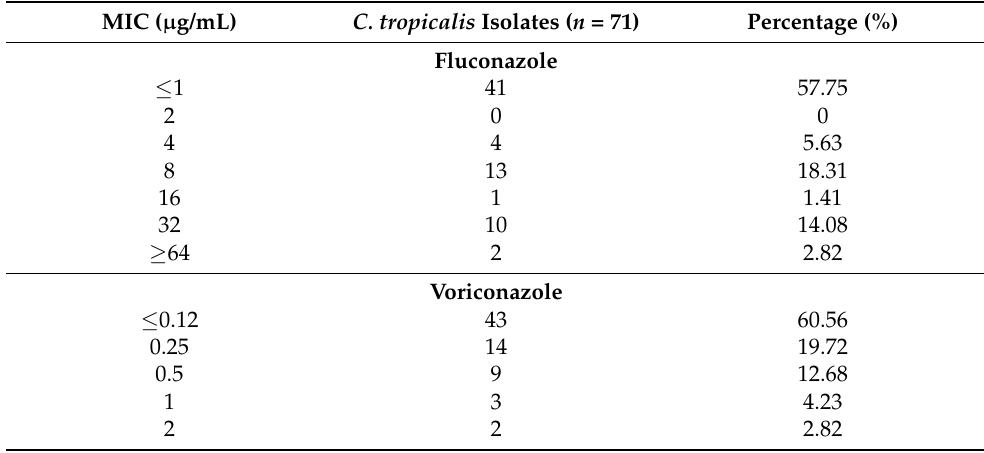
Table 2. Fluconazole and voriconazole MIC levels of C. tropicalis isolates determined by VITEK ® 2 compact system.